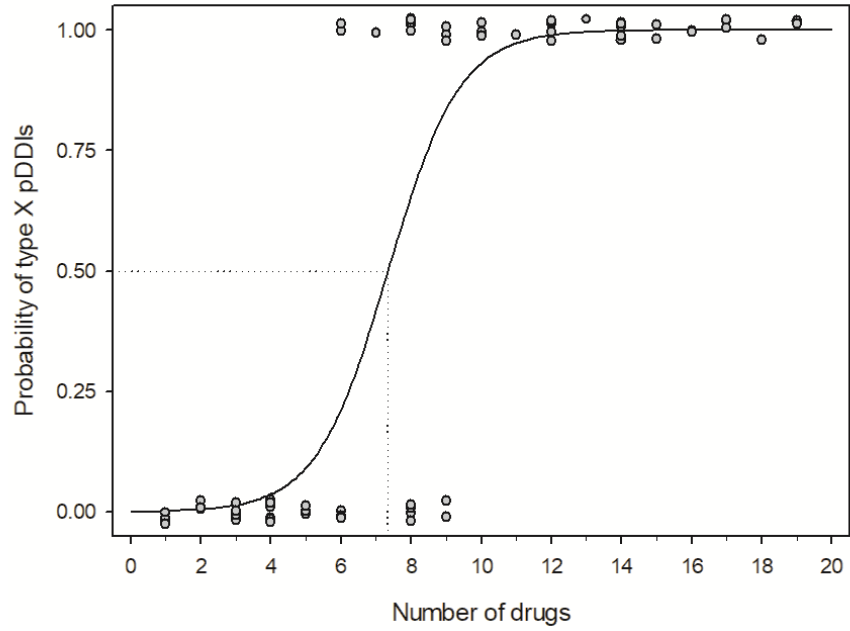
Figure 2. The probability of type X pDDIs in groups 1 and 2 of the studied population and association with the number of drugs.